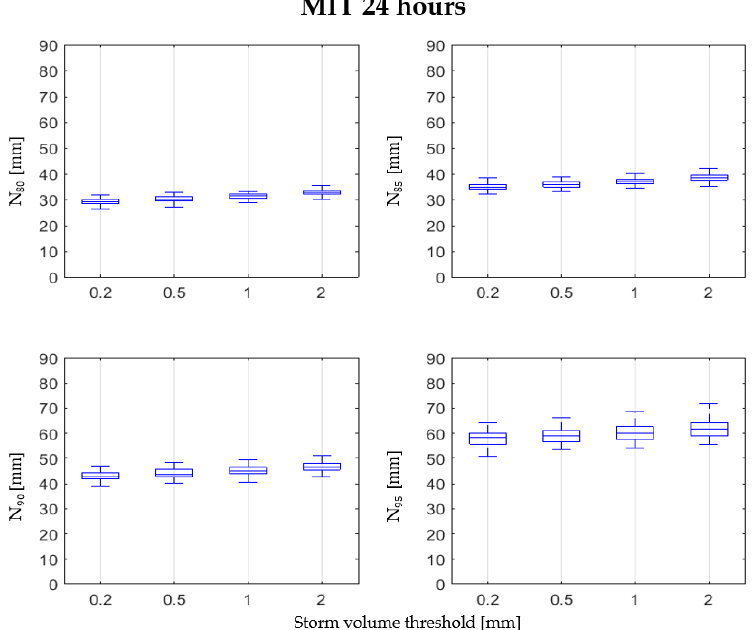
Figure 10. Effect of different storm volume thresholds on values of volumetric percentiles that treat a percentage of the total number of rainfall events, for simulated rainfall series and a fixed 24 h MIT value.